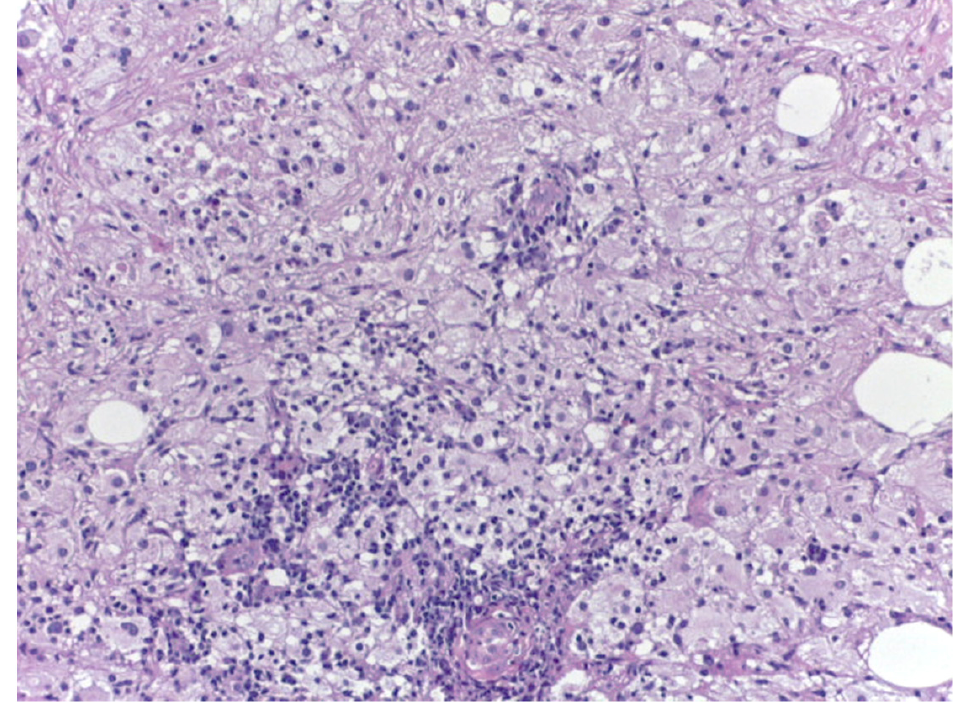
Figure 3. Rosai–Dorfman disease of the breast—haematoxylin–eosin (20×).